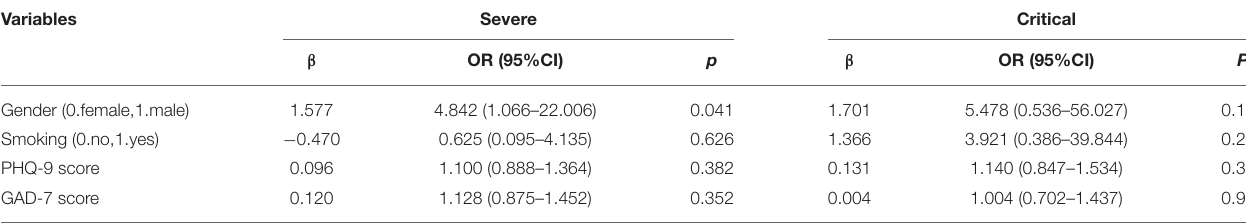
TABLE 4 | Multivariate logistic regression analysis on the clinical classification of 2019-nCoV.